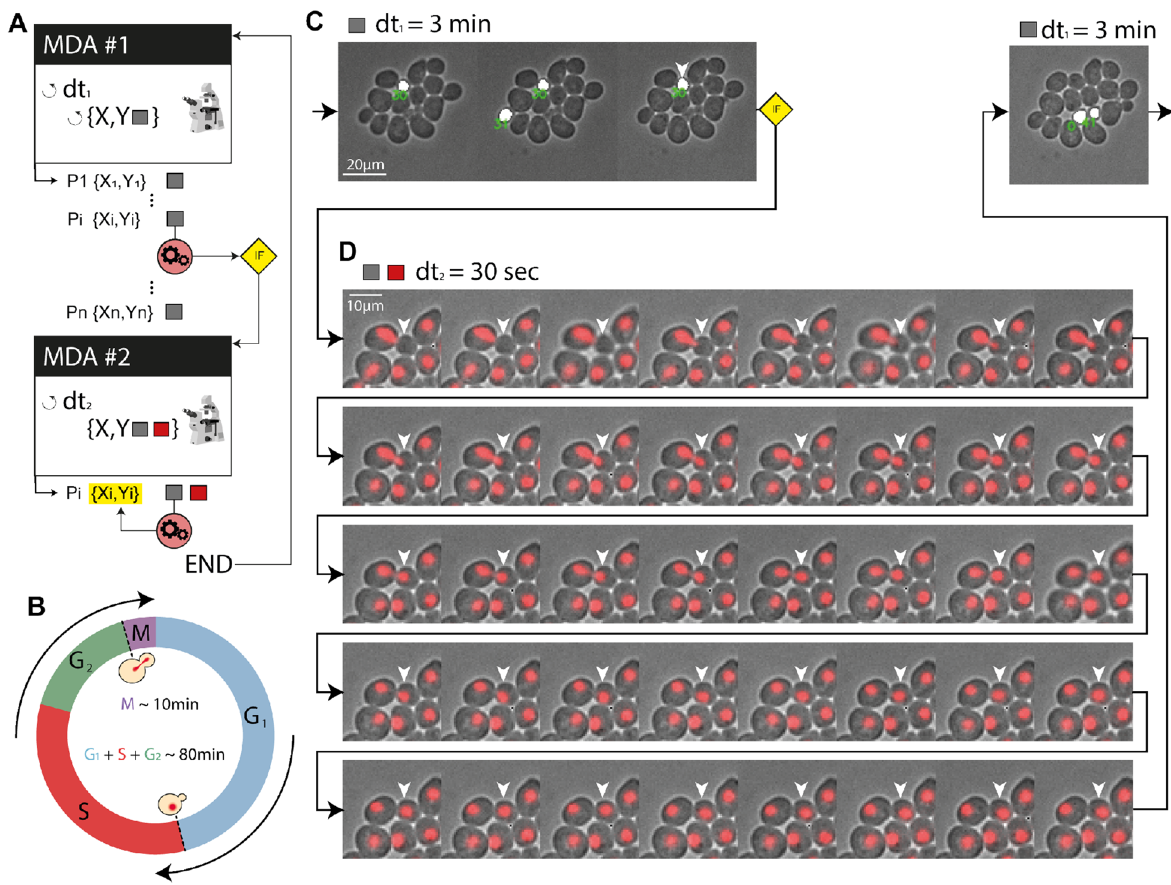
Figure 6. Bud detection and high-temporal-resolution imaging of mitosis. ( A ) Scenario used to detect and “zoom in” on a particular event (in this case, mitosis). Several positions are monitored and when a condition is fulfilled, image acquisition is performed on only this position at an adapted sampling framerate. ( B ) Cell cycle progression in yeast. The mitosis event to be captured represents a small-time fraction of the cell’s life cycle (~ 10%). ( C ) In practice, the acquisition of brightfield images of a population of budding yeast leads to a coarse timelapse with an acquisition framerate of 3 min to search for the next mitotic event. Cell segmentation is used to identify buds (size filtering), shown here as a white overlay. When a bud has reached a given size (and has been growing for at least three frames), we consider that a mitotic event is about to occur. ( D ) Then, the acquisition software “zooms in” on that cell by increasing the framerate to one frame every 30 s for 20 min and RFP imaging is added to image the nucleus (HTB2-mCherry reporter). As shown in panel ( D ), this scenario allows the complete mitotic event and nuclear separation between the mother and daughter cells (around 10 min, as expected) to be captured at an appropriate framerate. Once this image acquisition sequence is complete, the program resumes its search at the lower framerate for another mitotic